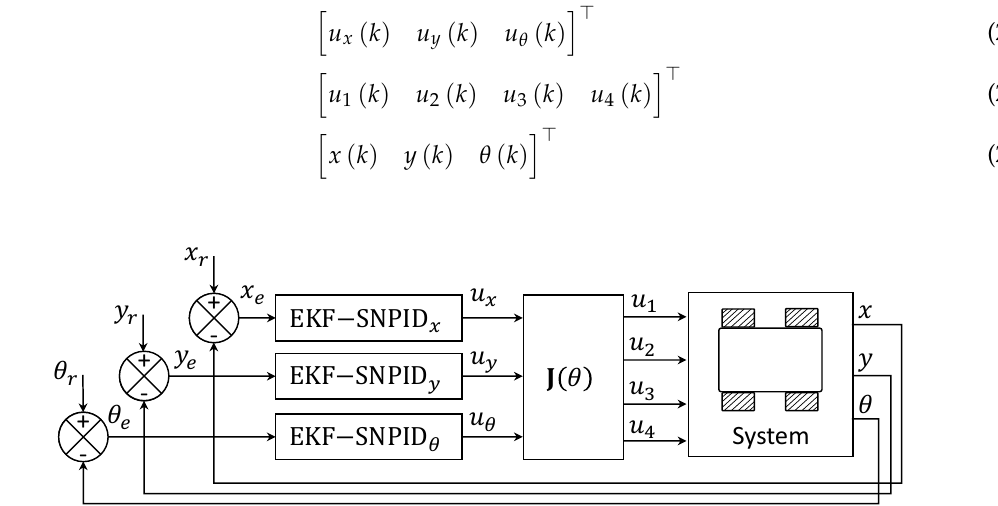
Figure 8. Adaptive single neuron anti-windup PID control scheme for a omnidirectional mobile